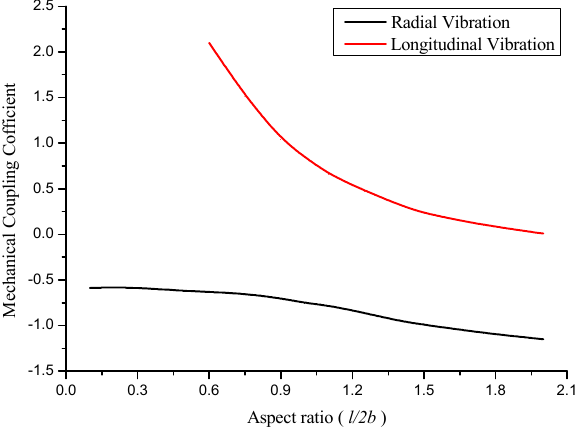
Figure 2. The relationships between mechanical coupling coefficient and aspect ratio.